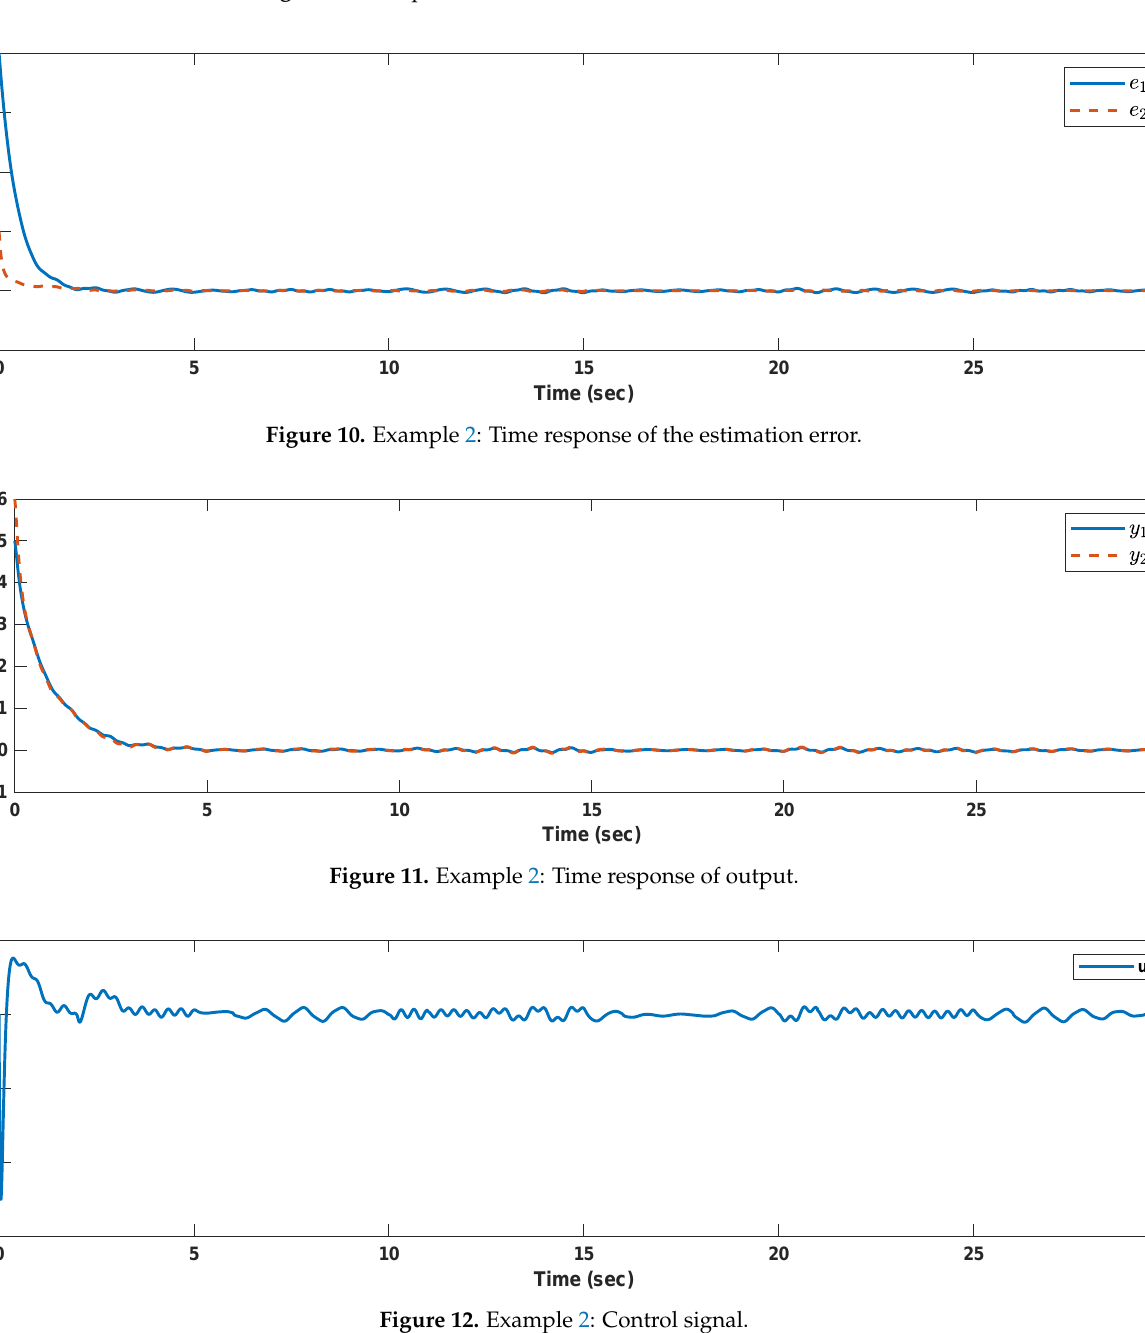
Figure 9. Example 2: Second state variable and its estimation.